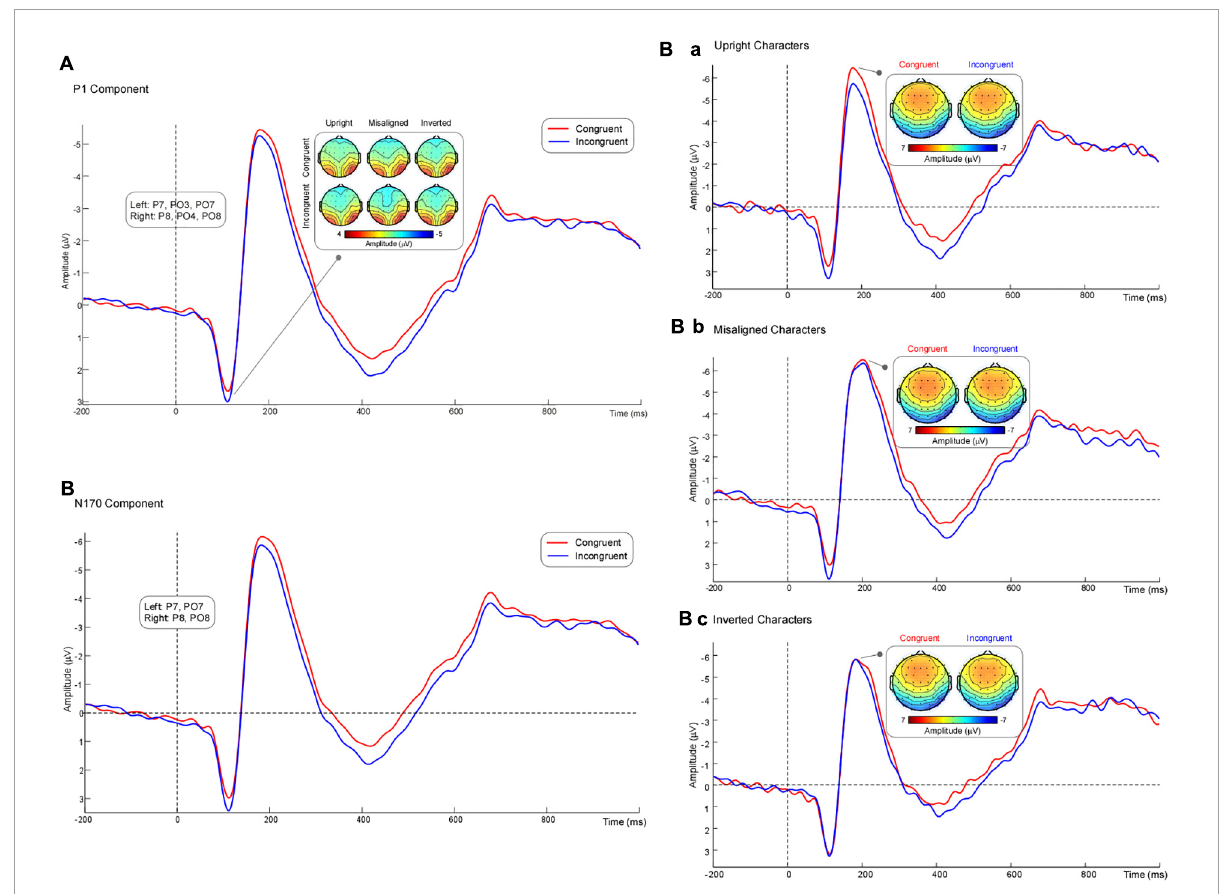
FIGURE3 (A) Grand average P1 waveform and scalp topographies. (B) Grand average N170 waveform. Average N170 waveforms and scalp topographies elicited by congruent trials and incongruent trials for upright (Ba) , misaligned (Bb) , and inverted (Bc) Chinese characters, respectively.